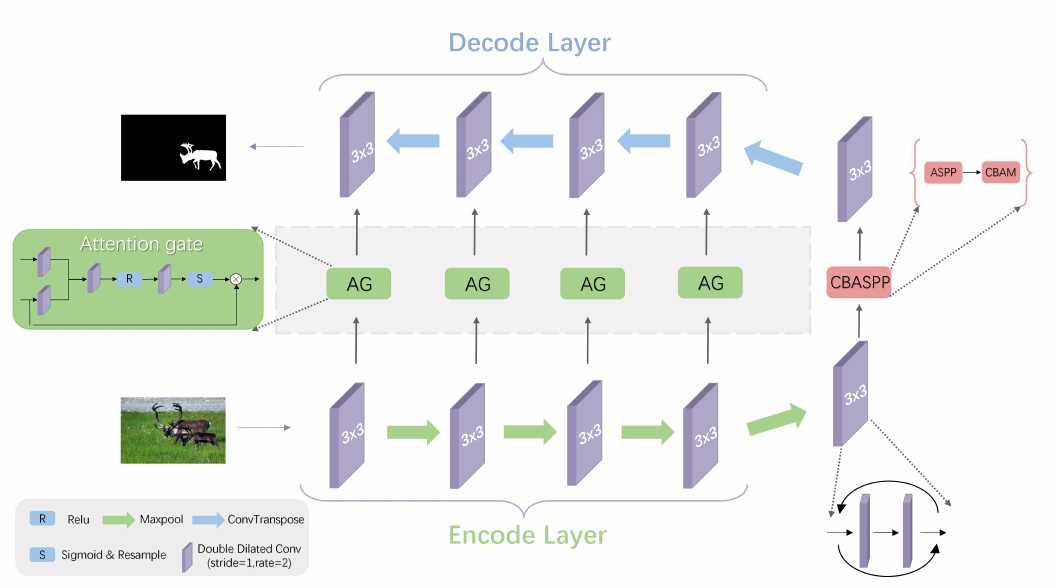
Figure 2. The overview of the proposed CAU-Net structure for the task of the location of tampered